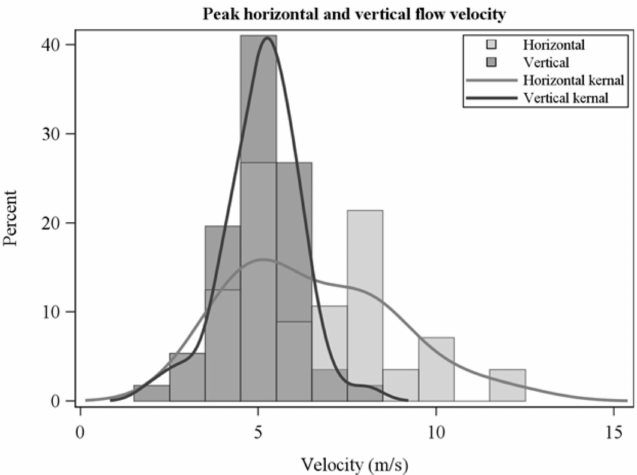
Figure 6. Peak horizontal and vertical flow velocities over residence times.